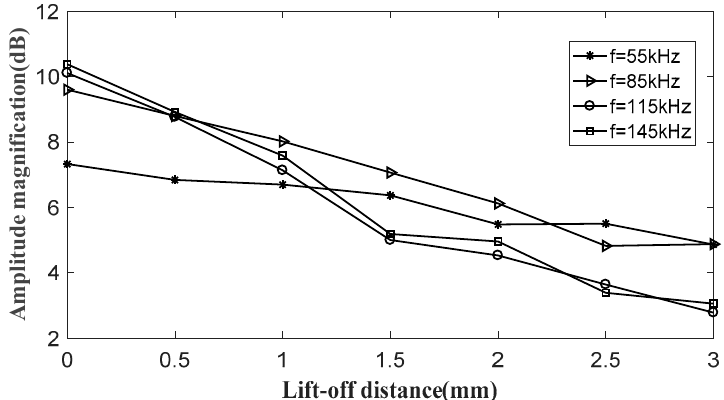
Figure 17. Amplitude magnification for the magnetostrictive patch transducer with different lift-off distances of the SMP at several typical frequencies. T1 was an actuator and sensor.